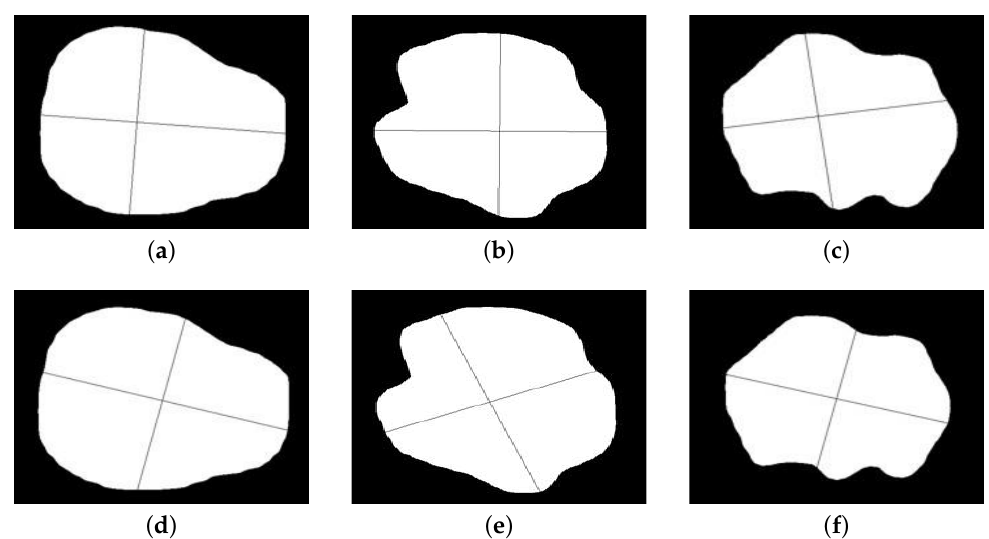
Figure 12. Long and short diameters of irregular timber sections. ( a – c ) calculate by incircle as the center. ( d – f ) calculate by circumcenter as the center.